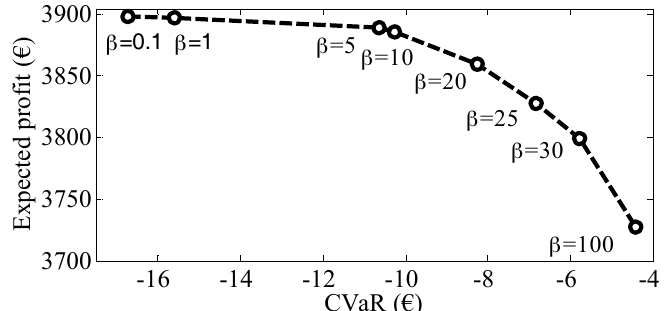
Figure 8. Variation of expected profit and conditional value at risk with varying β .